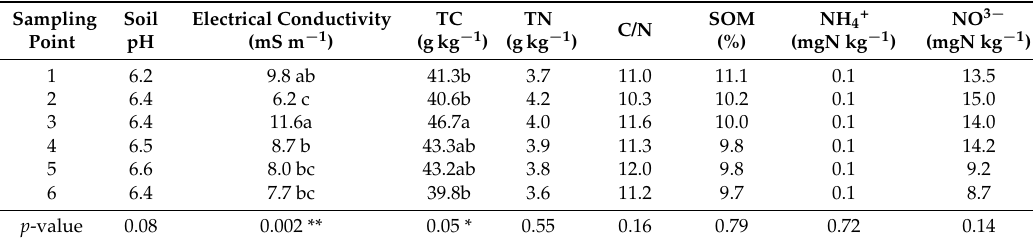
Figure 3. The averages of net radiation, air temperature, water temperature, and soil temperature at 0, 5, 10 and 20 cm soil depths of at ( a ) 30 DAT; ( b ) 60 DAT; ( c ) 90 DAT and ( d ) AHV. (No net radiation data for 30 DAT due to sensor defect). Table 1. CH 4 flux averages and chemical properties of soil at different soil sampling points at the experimental site during June to October 2014.